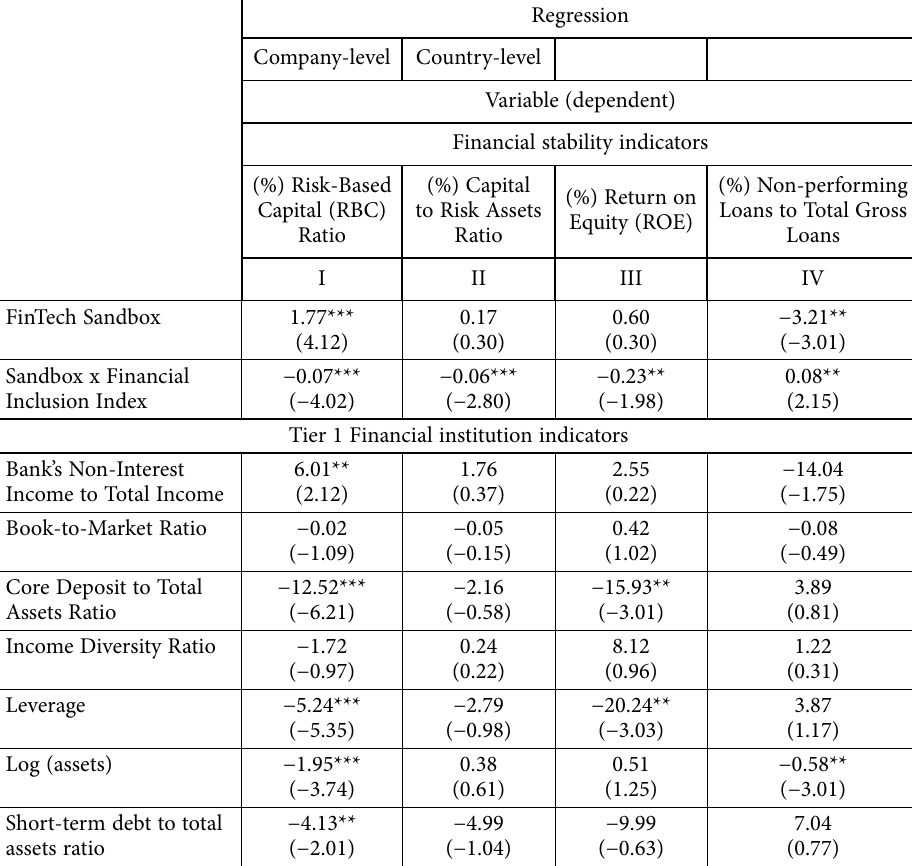
Table 7. Possible alternative options for measuring the impact of financial stability on the development of FinTech